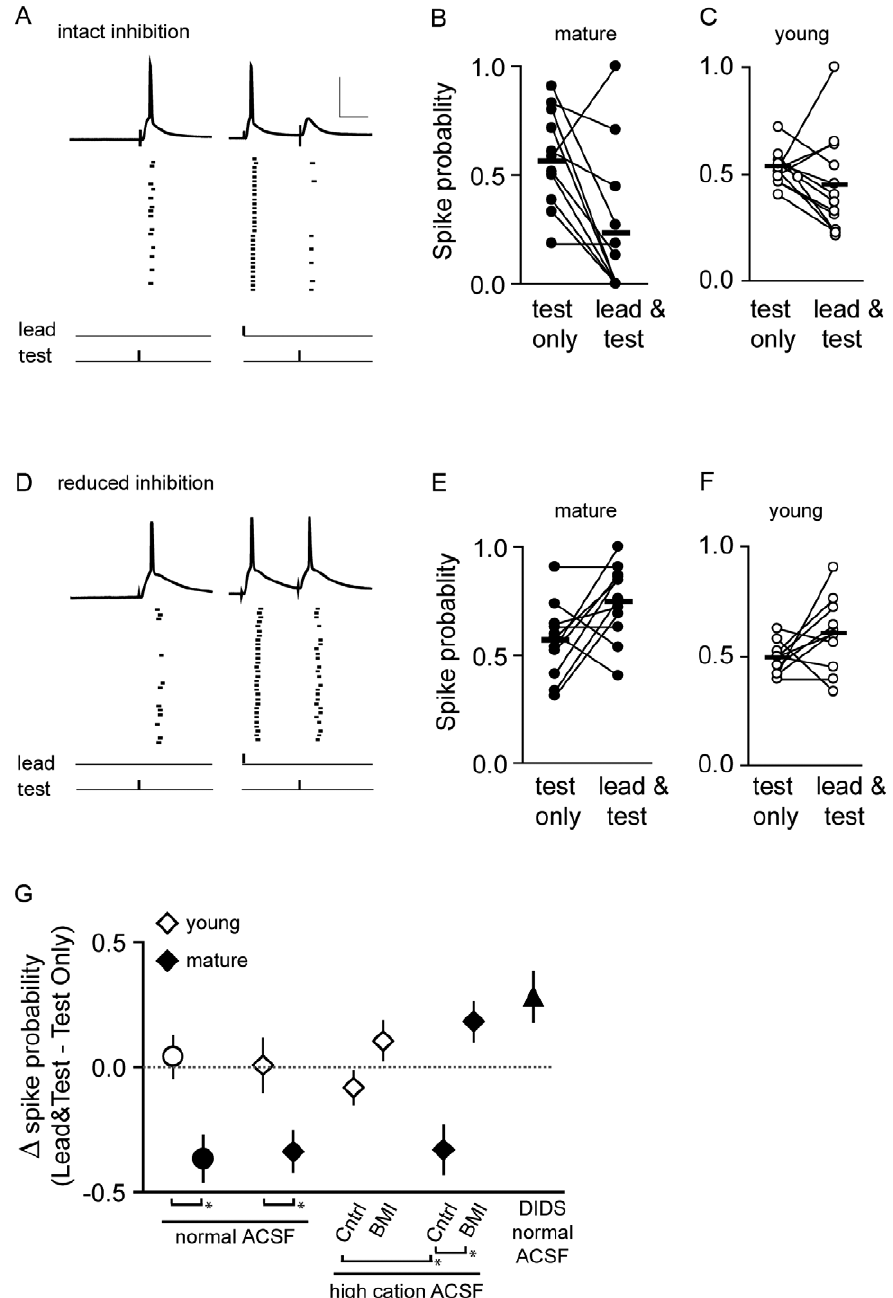
Figure 8. Reduction of synaptic efficacy of P test by P lead stimulation is mediated by synaptic inhibition. Whole-cell recording of spike probability of layer 2/3 pyramidal neurons in V1 in response to the Test Only and Lead-Test pathway stimulation paradigm (Figure 7A); bathing media contained high cations (3 mM CaCl 2 and 3 mM MgSO 4 ). (A) Example traces of two inter-leaved trials in response to pathway stimulation in mature slices with intact inhibition. Raster plots of spike events are shown below the traces. Spike probabilities of individual pyramidal neurons in response to Test Only and Lead-Test pathway stimulation with intact inhibition are then plotted for the mature (B) and young (C) age group. (D–F) Same as in A–C except inhibition was reduced with the application of 3 m M BMI. Scale bar: 50 mV, 20 ms. (G) Summary plot of the average differences in spike probability of layer 2/3 pyramidal neurons in response to Test Only and Lead-Test stimulation. Circles represent cell-attached recordings, diamonds and triangle represent whole-cell recordings. GABA B and NMDA-mediated currents were blocked. Asterisks denote a significance effect of treatment (p , 0.05), determined by ANOVA analysis.